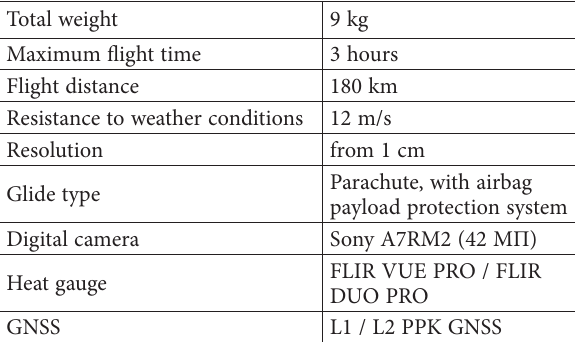
Table 1. Specifications of “Cetus” UAV (Hlotov,